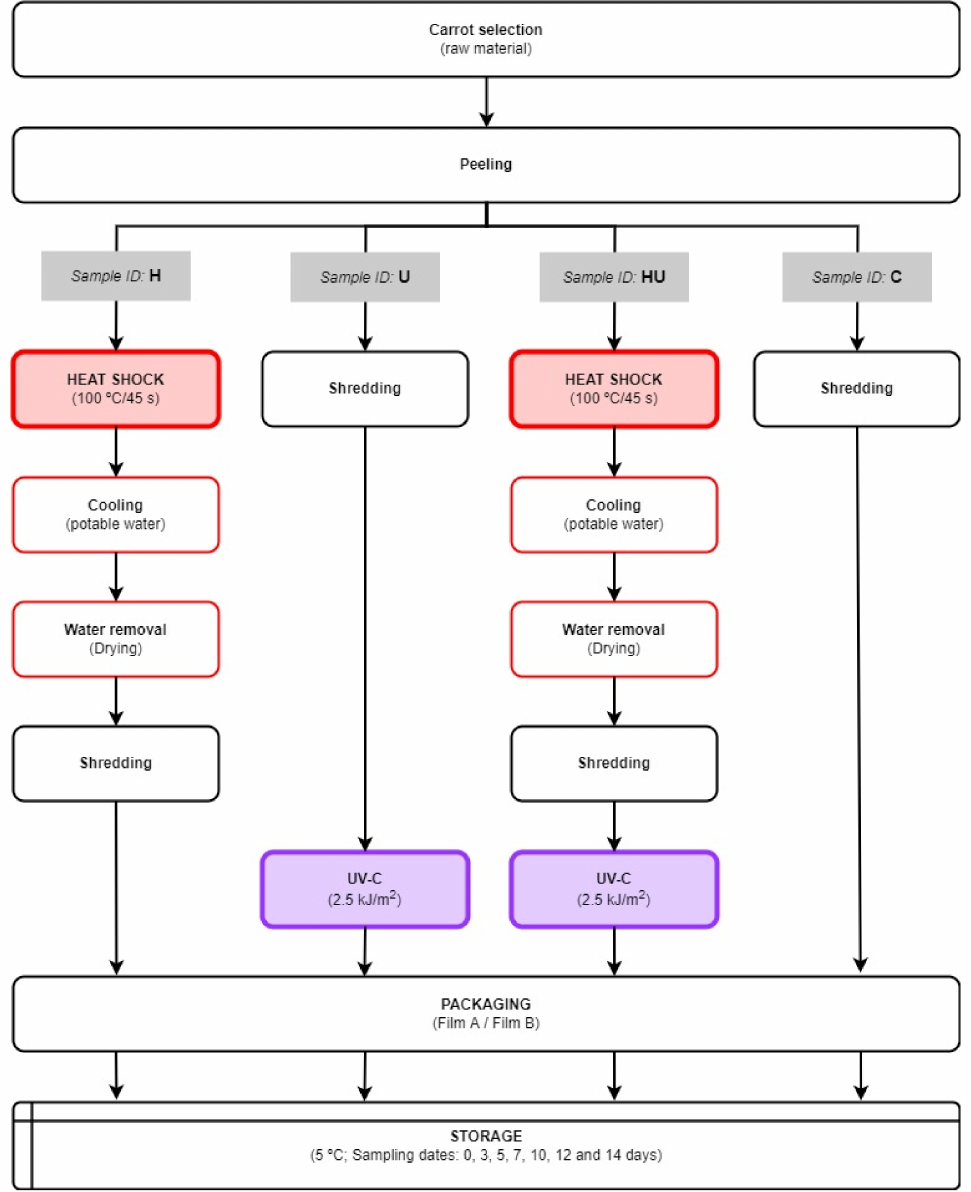
Figure 1. Flow diagram of minimal processing operations for preparing fresh-cut shredded carrots packaged under two MAP conditions according to the selected abiotic stress